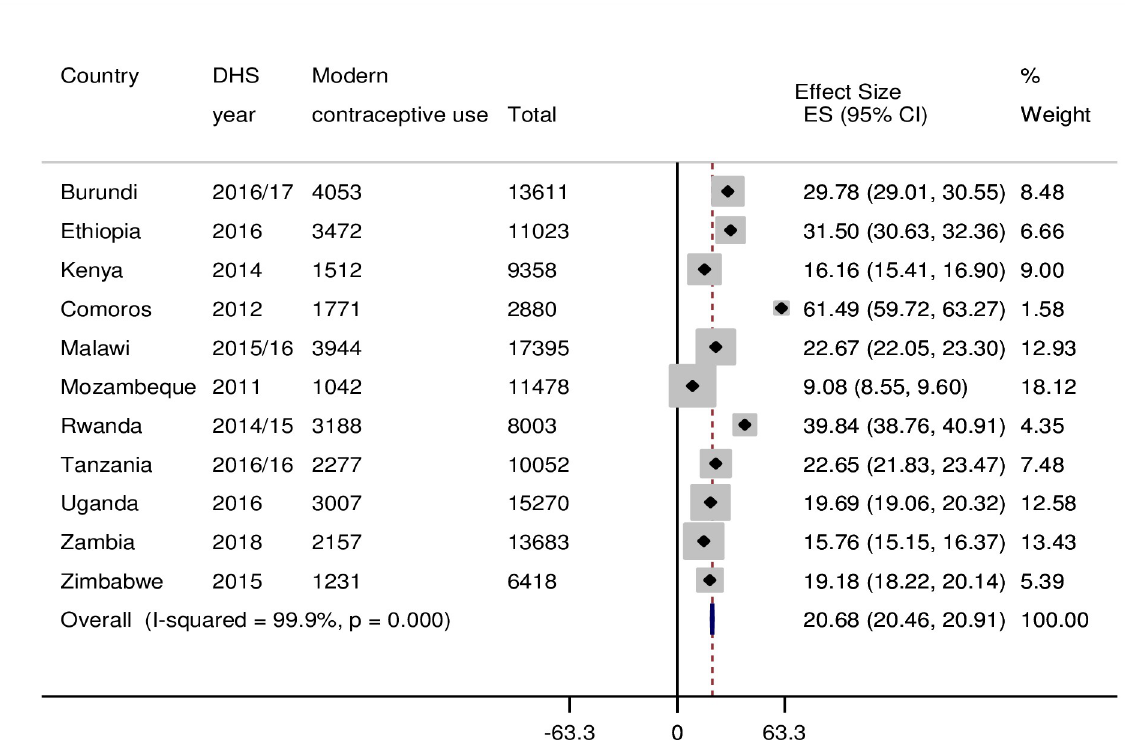
Fig 1. Forest plot of overall prevalence of modern contraceptive utilization in the 11 East Africa Countries from 2011 to 2018.